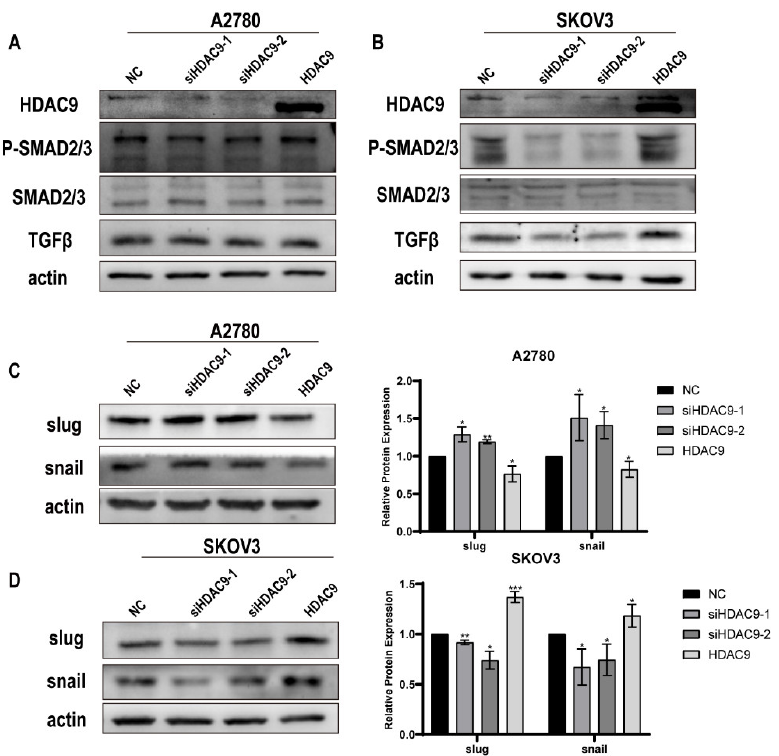
Figure 5. HDAC9 may promote EMT in SKOV3 cells by upregulating transforming growth factor- beta (TGF-β) signaling. A2780 and SKOV3 cells were transfected with a HDAC9 overexpression construct, HDAC9-shRNA plasmids (siHDAC9-1/2), or empty vector for 24 h. ( A , B ) The expression of HDAC9, P-SMAD2/3, SMAD2/3, and TGF-β in A2780 and SKOV3 cells was measured by Western blot. ( C , D ) Western blotting determined the expression of snail and slug in A2780 and SKOV3 cells (means ± SD, n = 3, * p < 0.05, ** p < 0.01, *** p < 0.001), compared with NC group. 3.6. HDAC9 May Inhibit EMT in A2780 Cells by Suppressing β-catenin Signaling As the core transcriptional coactivator of the classical Wnt pathway, β-catenin pro-